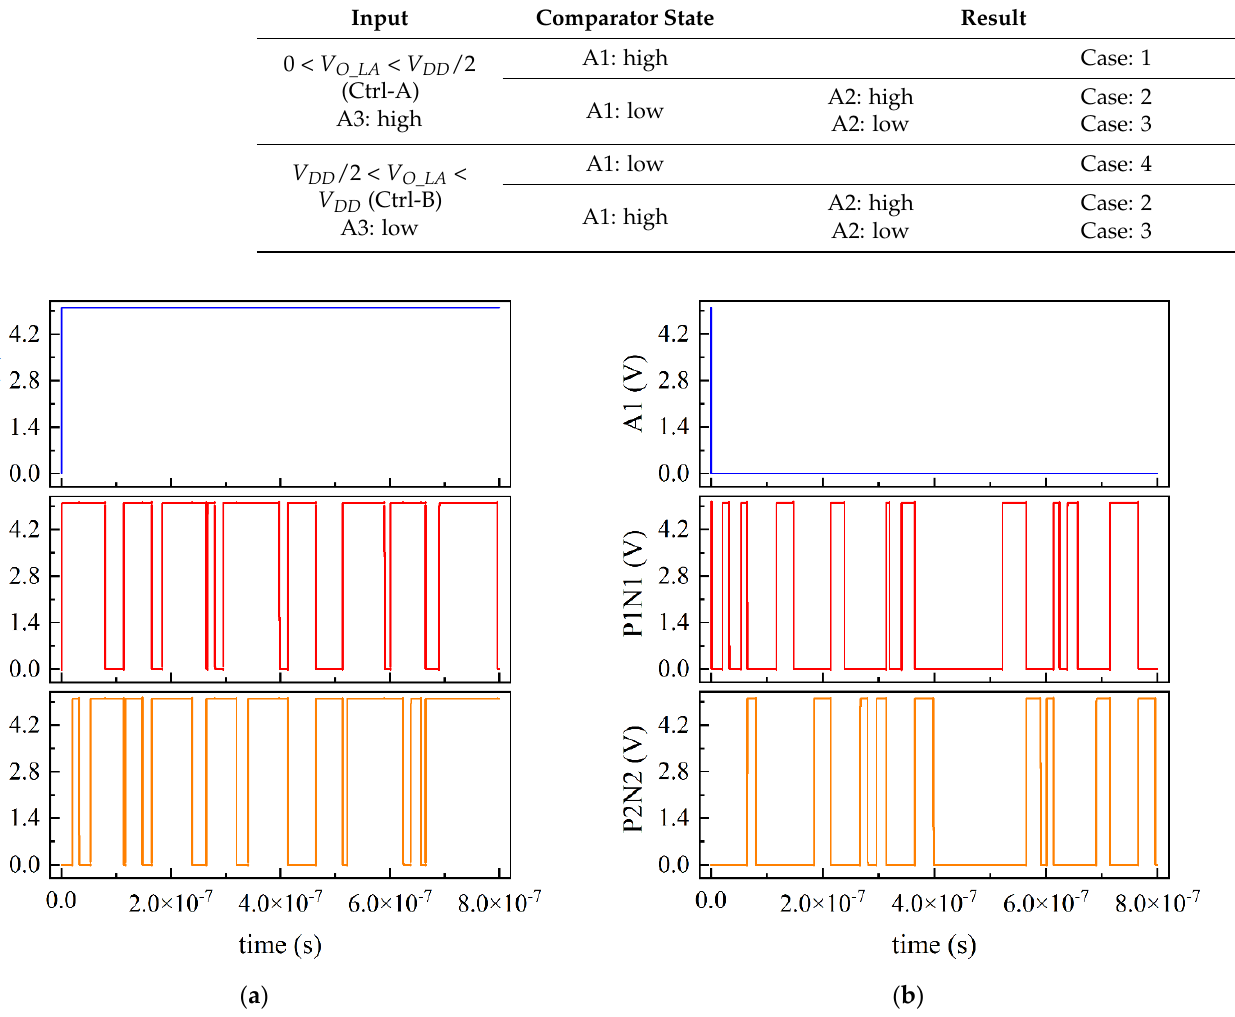
Figure 11. The logic results of control loop: ( a ) A1 output is high; ( b ) A1 output is low.